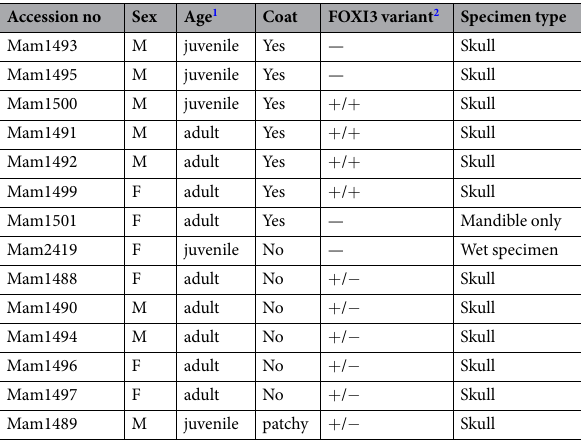
Table 1. Sample list. 1 Adult: > 4 months; permanent molars erupted; juvenile: < 4 months; deciduous teeth erupted, some or all permanent molars unerupted. 2 + / + = Two copies of 119-bp allele present; + / − = one copy of 119-bp allele and one copy of 126-bp allele present; − = no/insufficient DNA yield.